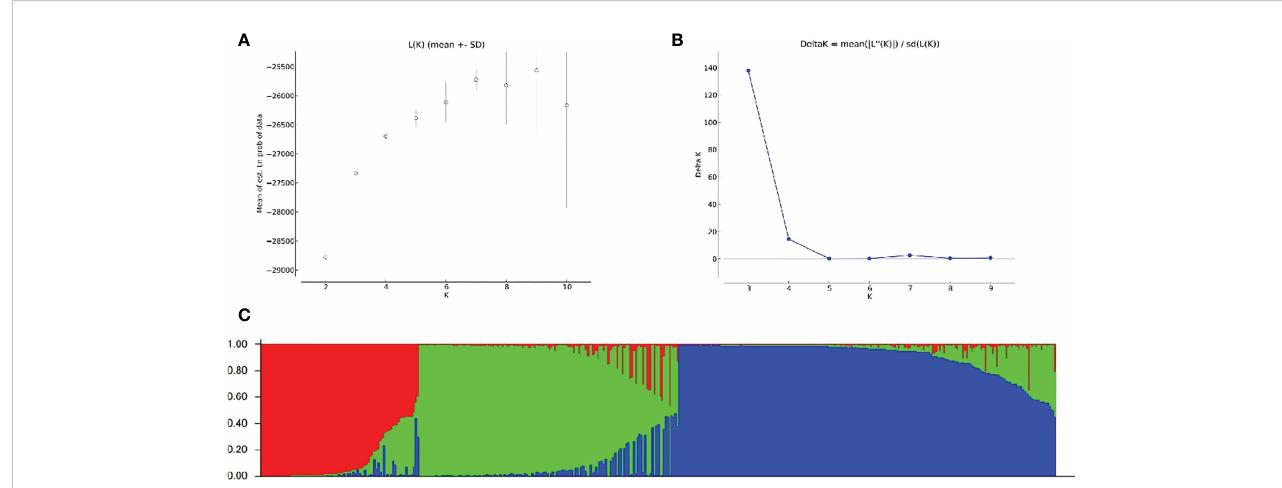
FIGURE 5 Population structure analysis of 423 non-heading Chinese cabbage varieties based on 23 simple sequence repeat (SSR) markers. (A) The mean value of ln P (D) was used to estimate the population structure, and the range of K -values was 1 – 10. (B) Using the curve of D K obtained by ln P (D), the optimal K -value was determined to be 3. (C) The 423 non-heading Chinese cabbage varieties studied clustered in three subgroups (subgroup I, red; subgroup II, green; and subgroup III, blue). Each histogram represents a variety in which different colors represent the estimated component coef fi cients using Q -values.